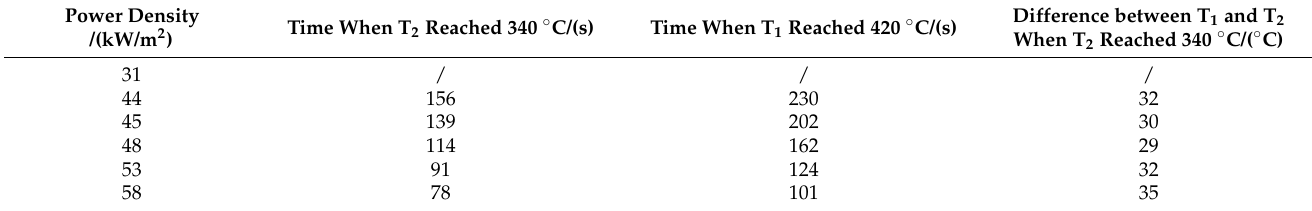
Table 4. Welding time at specific temperatures and temperature differences at the joining interface obtained with type C heating element at different power